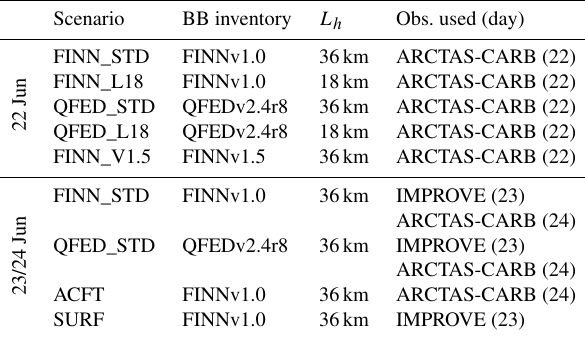
Table 1. Emission inversion